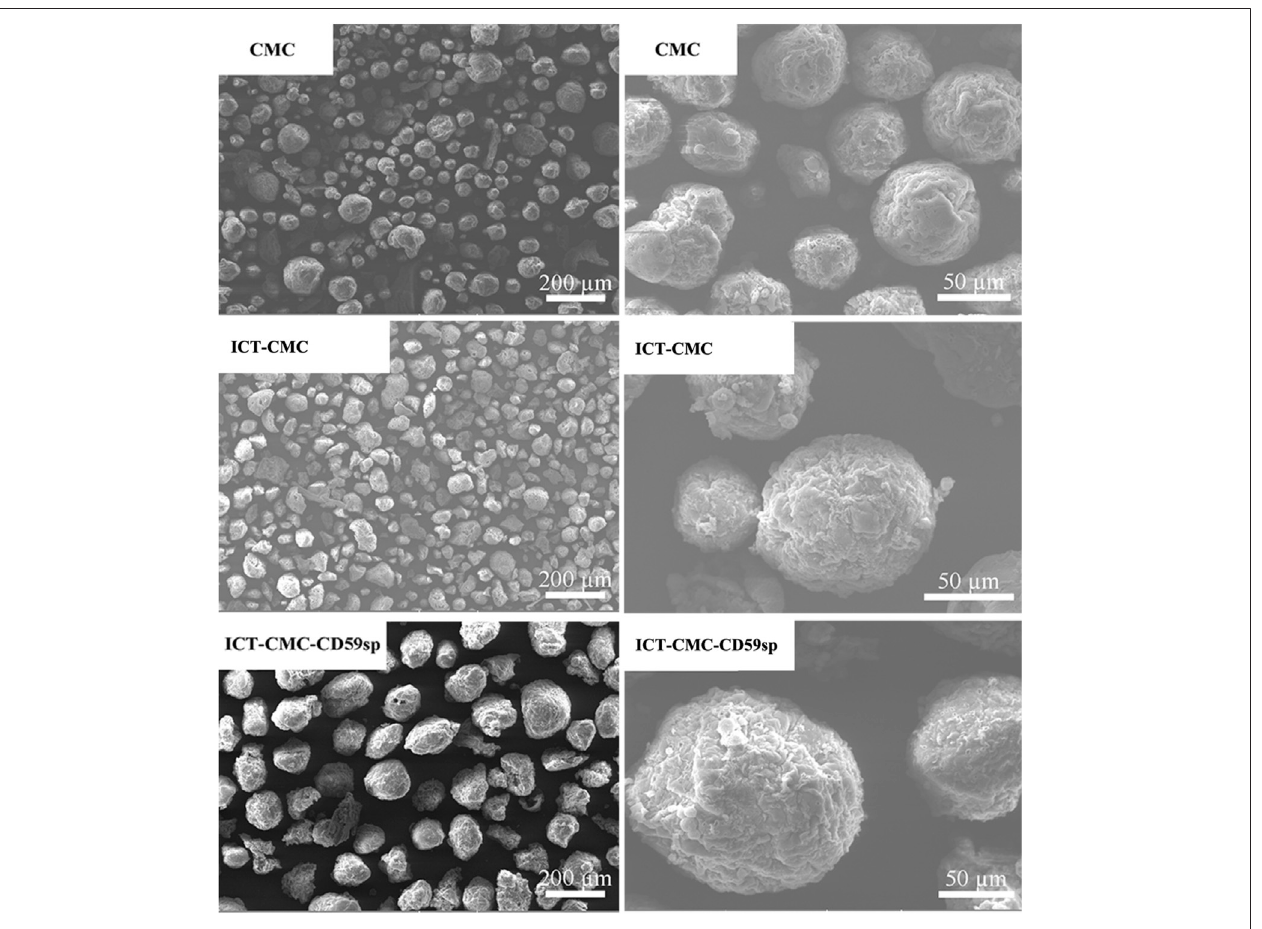
FIGURE 3 | Images of CMC, ICT-CMC, and ICT-CMC-CD59sp microspheres.